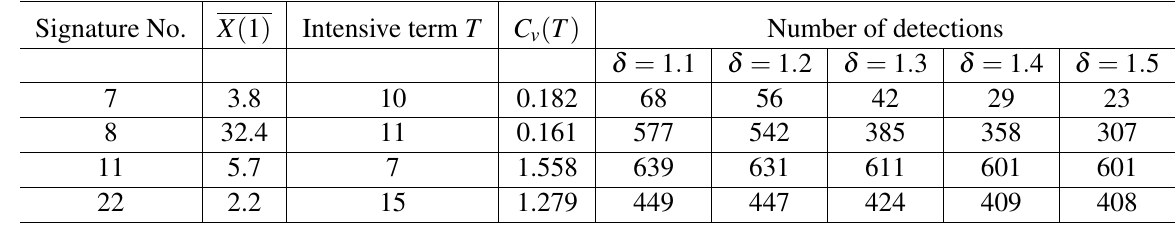
Table 1: Detailed information for the major target signatures.